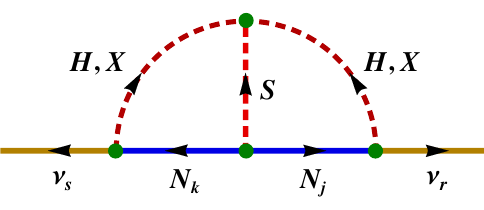
Figure 1 . Feynman diagrams for neutrino mass generation at the two-loop